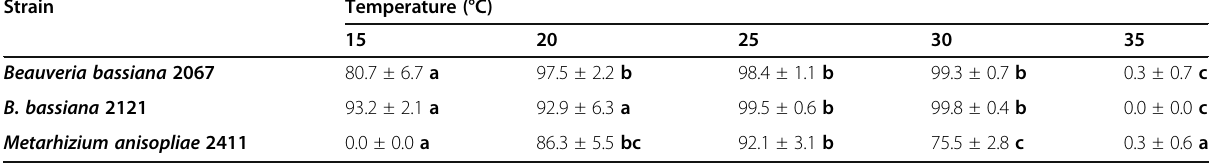
Table 3 Spores viability (germination percentage) at different temperatures Strain